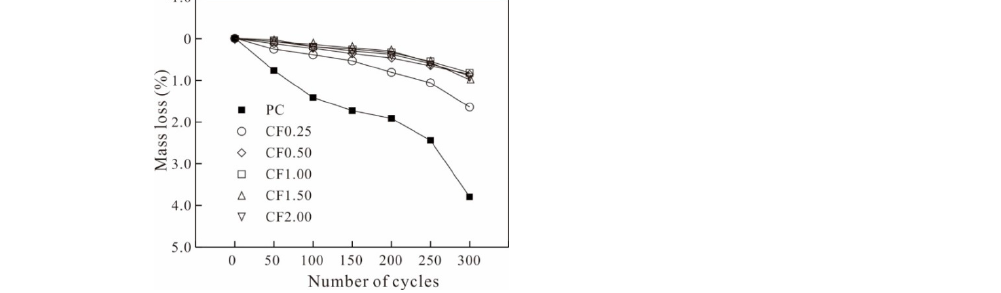
Figure 5. Mass losses of the carbon-fiber-reinforced concrete (CFRC) after different numbers of freeze–thaw cycles. CF, carbon fiber; PC, plain concrete.